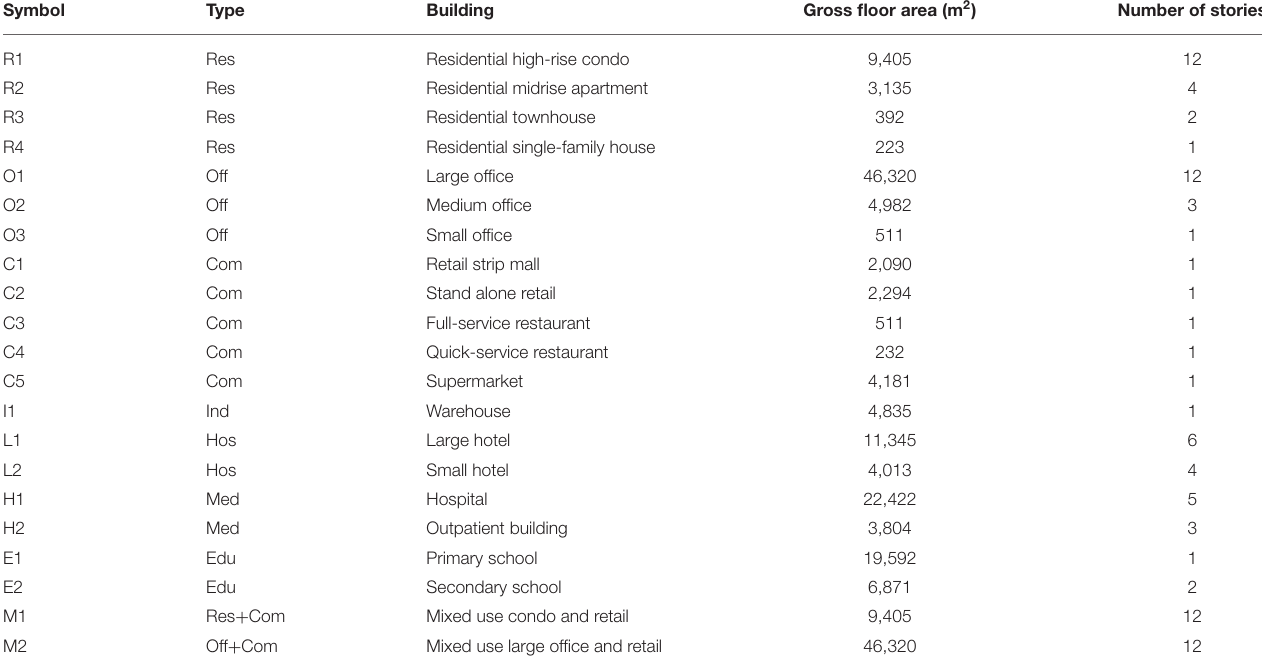
TABLE 1 | Specifications of each building type—modified from Best et al. (2015). Symbol